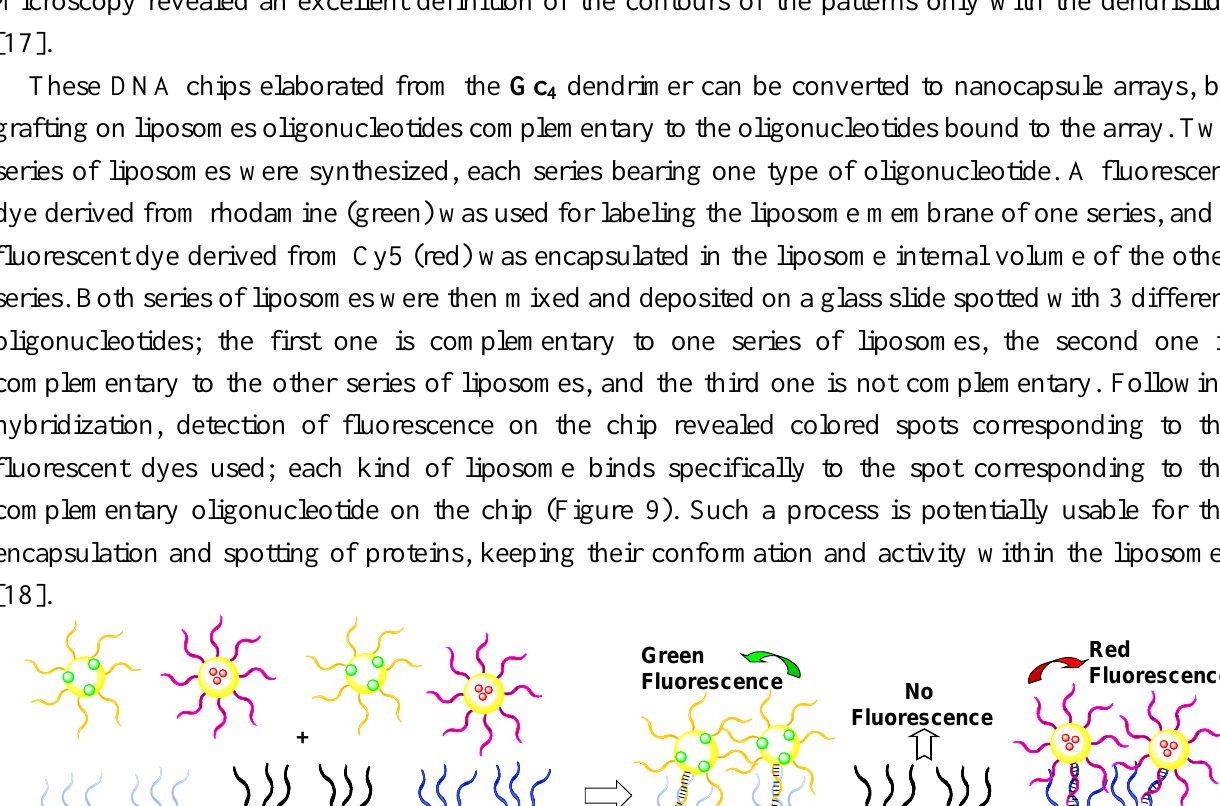
Figure 9. Specific liposome attachment to the array constituted of Gc complementary oligonucleotide hybridization; attachment is detected by